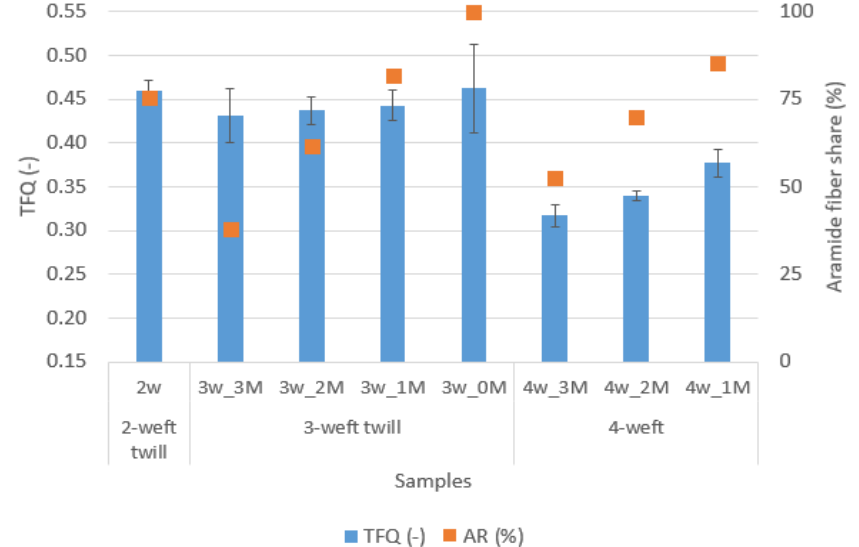
Figure 8. Correlation between TFQ and aramid fiber content in fabric.